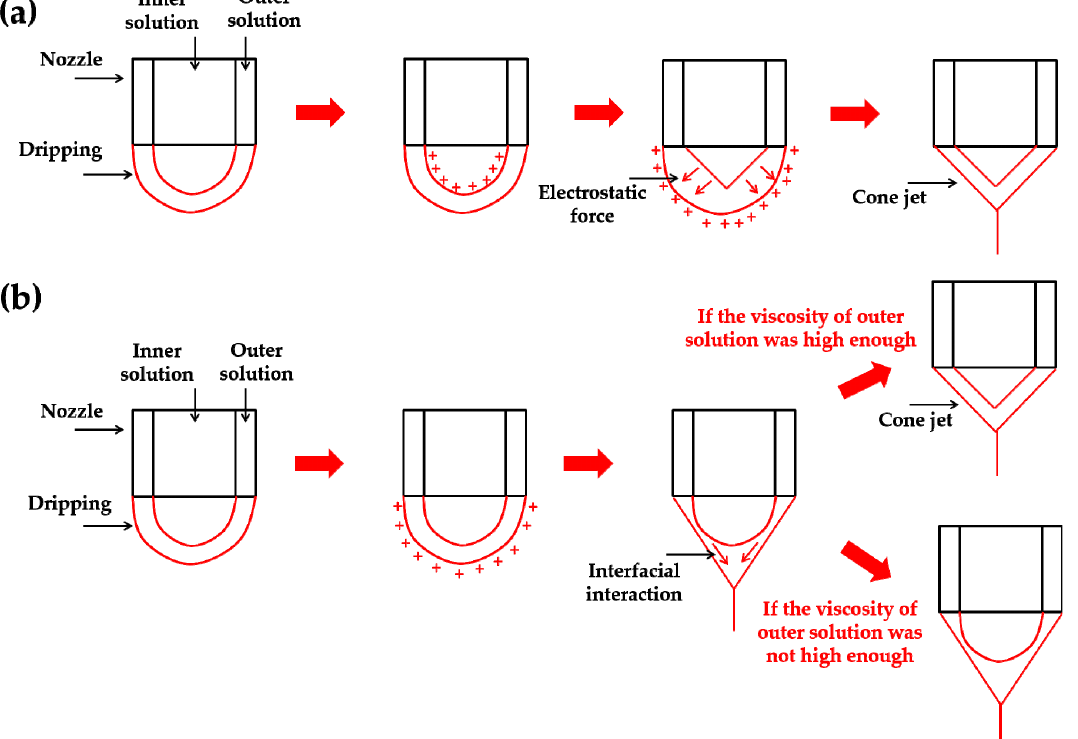
Figure 3. The formation process of cone jet in coaxial electrospraying for inner and outer solutions with different electrical conductivities. ( a ) inner solution has higher electrical conductivity ( b ) outer solution has higher electrical conductivity.